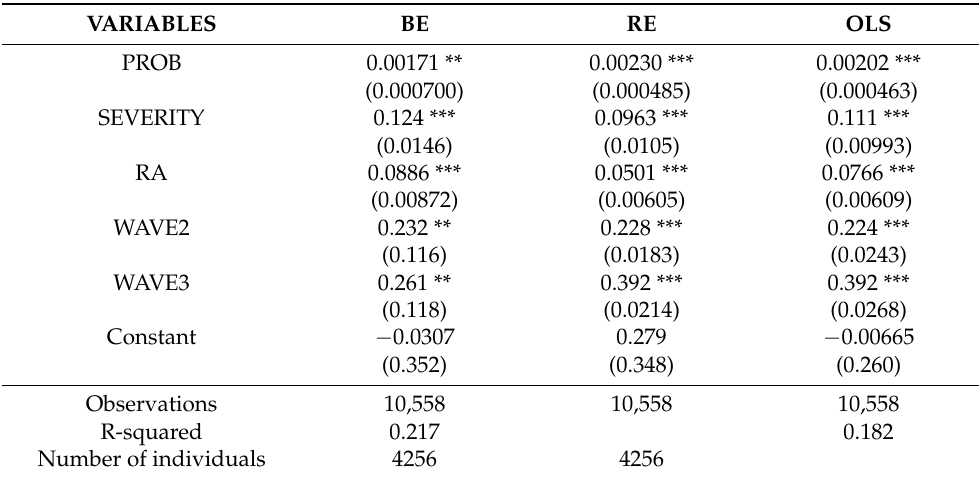
Table 9. Estimation results of between-effects (BE), random-effects (RE), and ordinary least squares